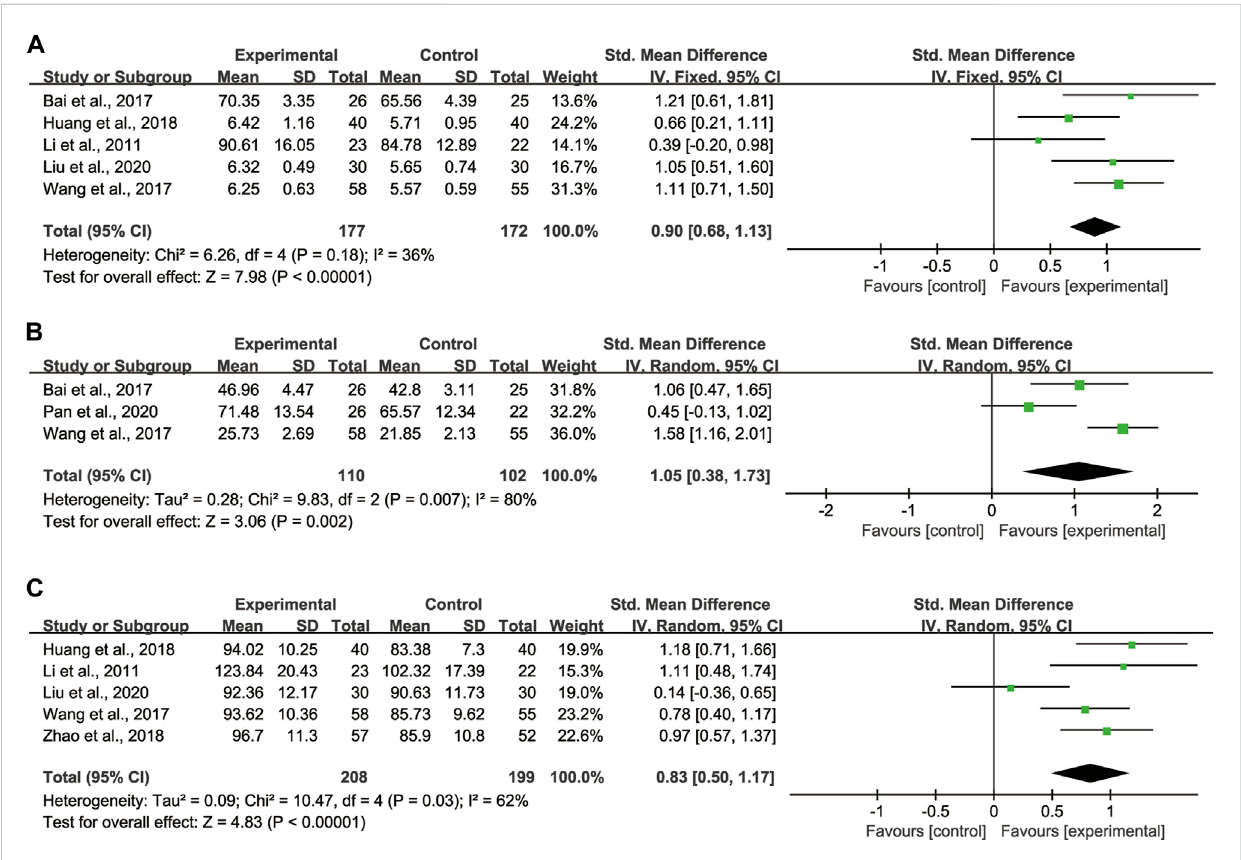
FIGURE 5 Forest plot of lung function: CHMs plus CTX treatment versus CTX treatment. (A) TLC, (B) DLCO, (C) MVV.